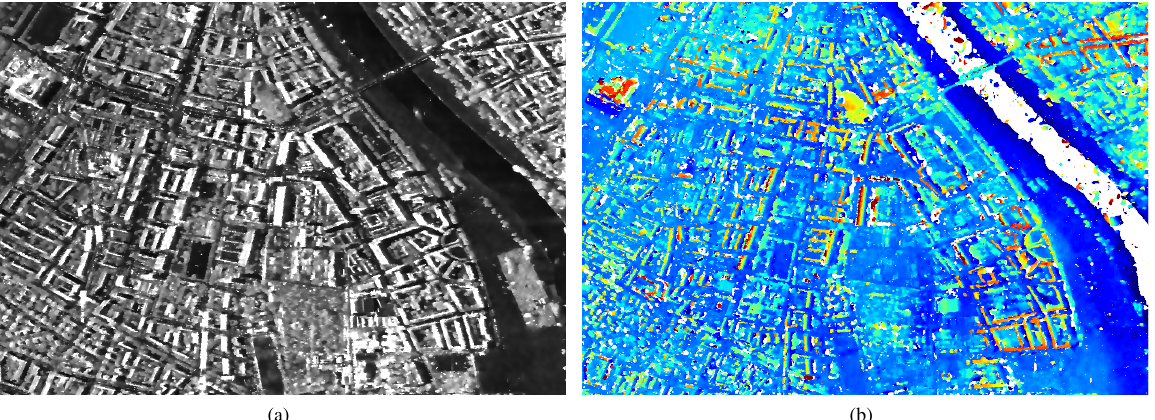
Figure 10: (a) Filtered covariance (intensity image) and (b) tomographic height map for the whole area of interest.